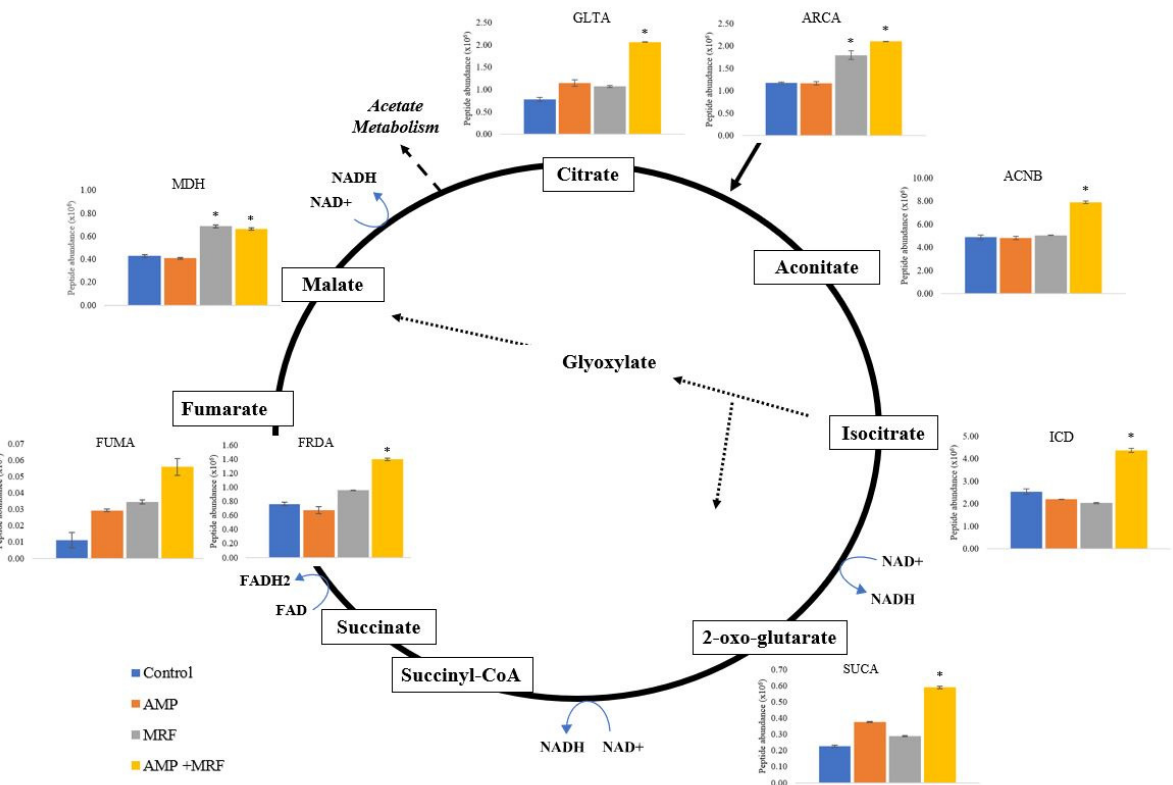
Figure 3. The influence of MRF on the translation of key intermediates of the citric acid cycle. The figure illustrates a comparison of normalized peptide abundance of control, AMP (0.1 mgmL − 1 AMP), MRF (1 mgmL − 1 ), and a combination of AMP (0.1 mgmL − 1 ) + MRF (1 mgmL − 1 ) cultures. Standard error is represented by error bars. Means that were significantly different to control are marked with an asterisk (*); p ≤ 0.05, ANOVA. Abbreviations: GLTA, citrate synthase; ARCA, aerobic respiration control protein; ACNB, aconitate hydratase; ICD, isocitrate dehydrogenase (NADP); SUCA, 2-oxoglutarate dehydrogenase E1 component; FUMA, fumarate hydratase class I; FRDA, fumarate reductase flavoprotein subunit; MDH, malate dehydrogenase.